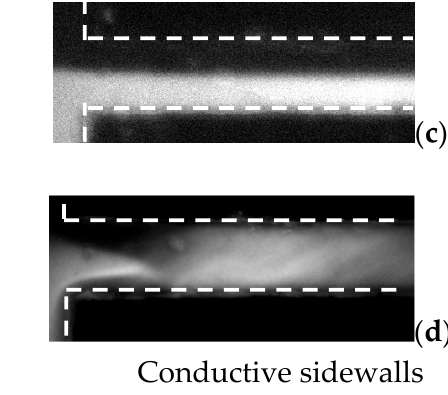
Figure 5. Visualization and comparison of mixing result in micromixer with electrodes located at ends of channel ( a , b ) and micromixer with conductive sidewalls ( c , d ), ( a ) without voltage, ( c ) with voltage; sidewall, ( b ) without voltage, and ( d ) with voltage.